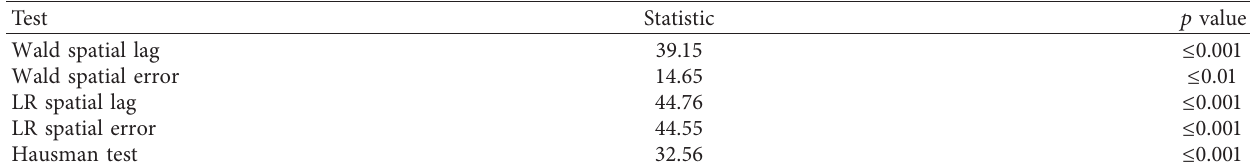
Table 5: Wald test and LR